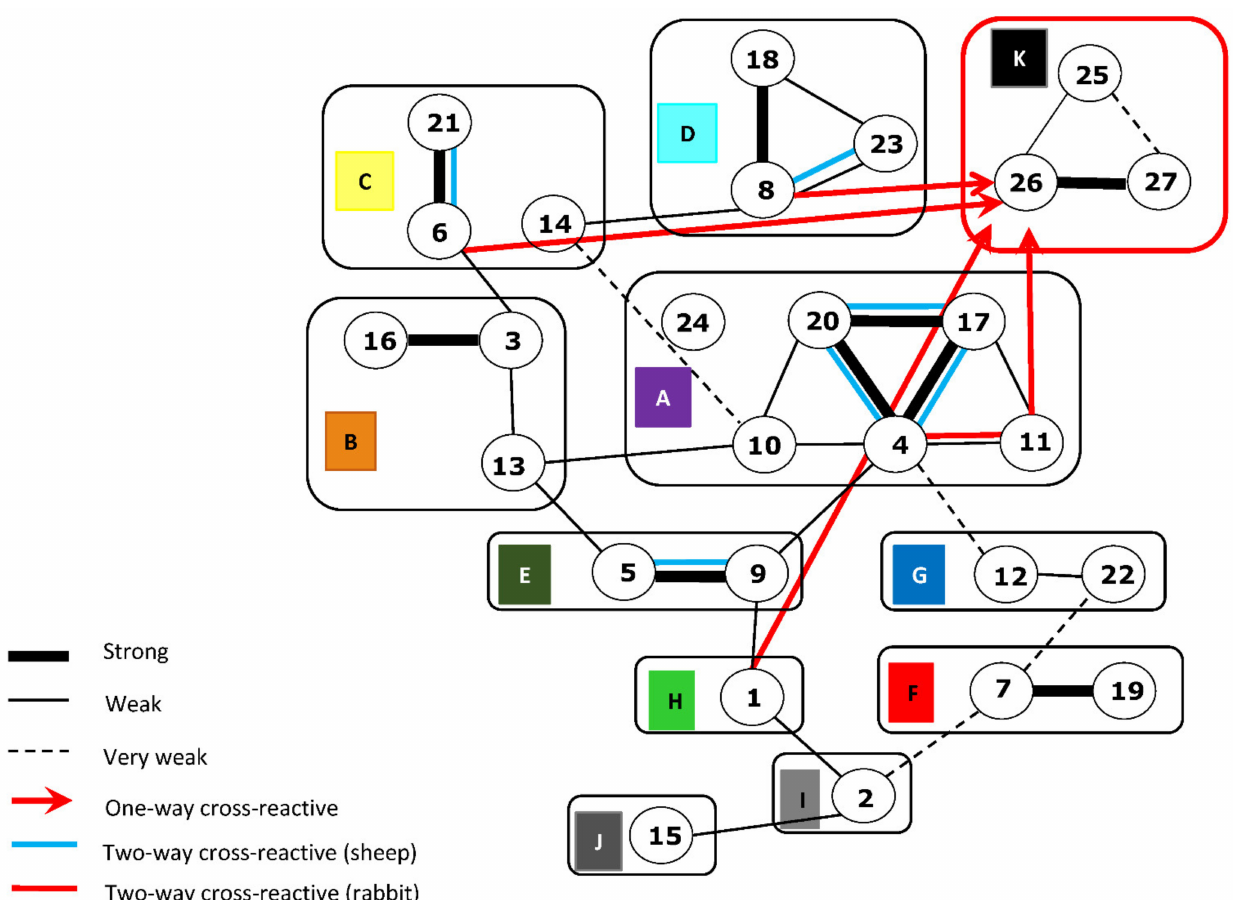
Figure 3. Antigenic relationships between BTV serotypes: The BTV serotype antigenic map, originally developed by Erasmus (1990) [35] to summarise relationships between BTV serotypes, has been modified to include two-way cross- reactions in SNT, detected here with the rabbit anti rVP2 sera (in red) and sheep reference-antisera (in blue). A strong, two-way cross-reaction is shown by a thick black connecting line in the original map, weak reactions by a thin black connecting line and very weak reactions by a dotted black connecting line. The novel BTV serotypes BTV-25, -26 and -27 are included as nucleotype K (red box). The red arrows indicate one-way reactions by rabbit anti-rVP2 sera with BTV-26. Several other one way cross-reactions were also detected in the current study with the rabbit or sheep sera but are not shown in this